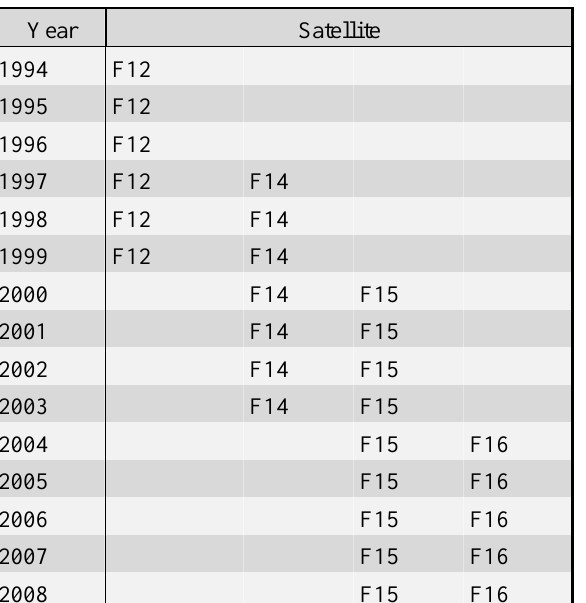
Table 1. Annual composites